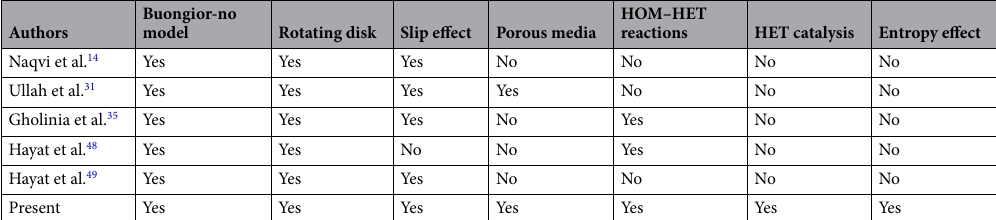
Table 1. Literature survey for uniqueness of the presented model.